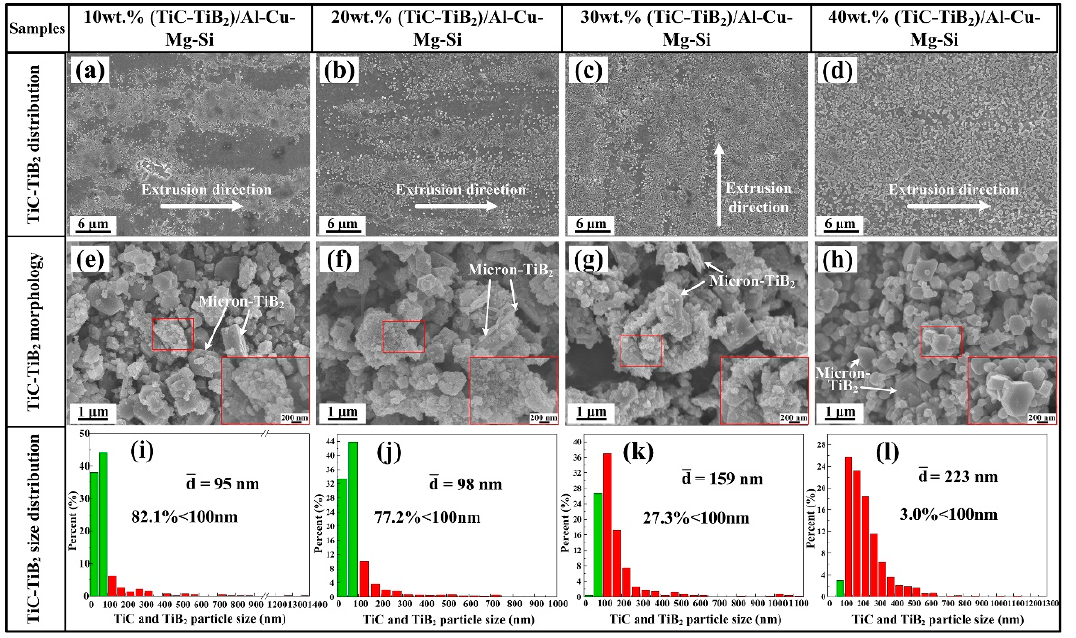
Figure 4. FESEM images of TiC-TiB 2 particle distribution and morphology, and size distribution diagrams. ( a , e , i ) 10 wt.% (TiC-TiB 2 )/Al-4.7Cu-0.32Mg-0.44Si; ( b , f , j ) 20 wt.% (TiC-TiB 2 )/Al-4.7Cu- 0.32Mg-0.44Si; ( c , g , k ) 30 wt.% (TiC-TiB 2 )/Al-4.7Cu-0.32Mg-0.44Si; ( d , h , l ) 40 wt.% (TiC-TiB 2 )/Al- 4.7Cu-0.32Mg-0.44Si. The green bars in Figure 4(i–l) represent the percentage of nano-sized parti- cles, while the red represents the percentage of sub-micron and micron sized particles.